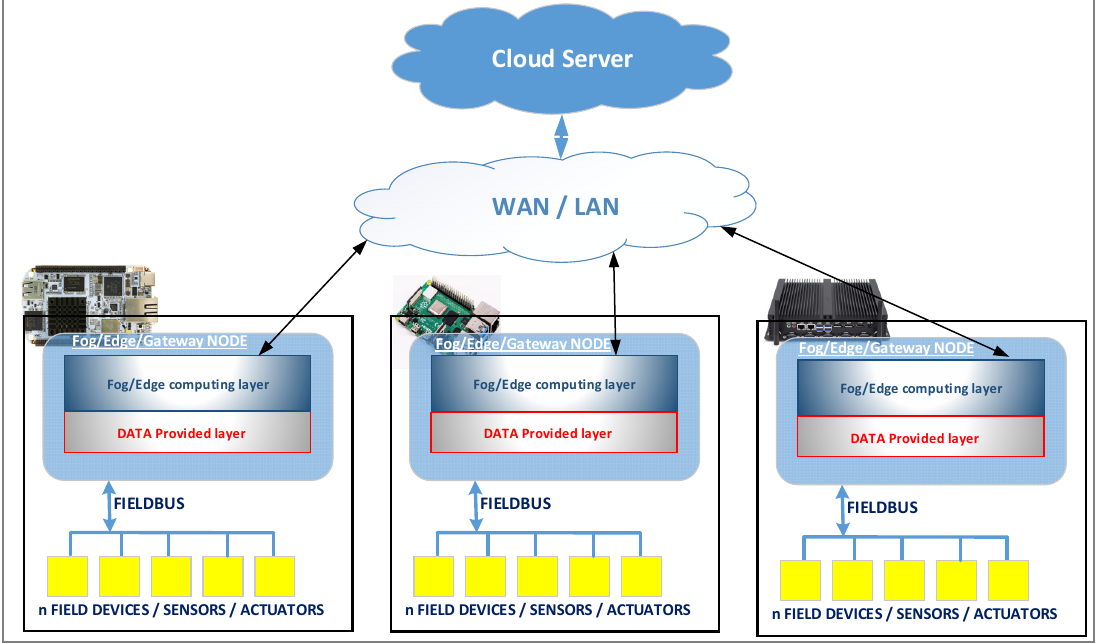
Figure 2. Other perspective of the proposed IIoT architecture based on fog/edge/gateway nodes.